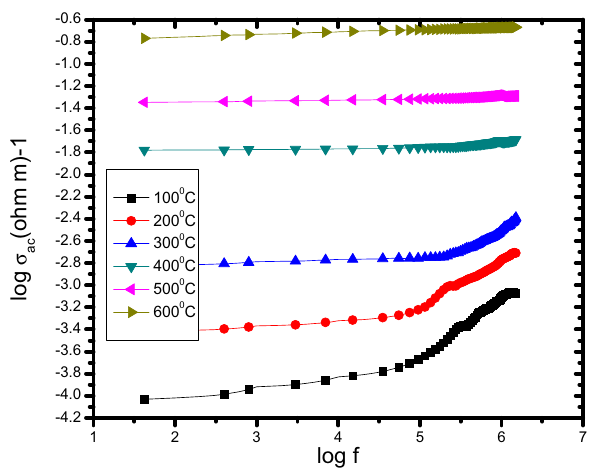
Fig. 5. Frequency dependence of the electrical conductivity for Pb 2 Sr 2 CaCu 2 O 9